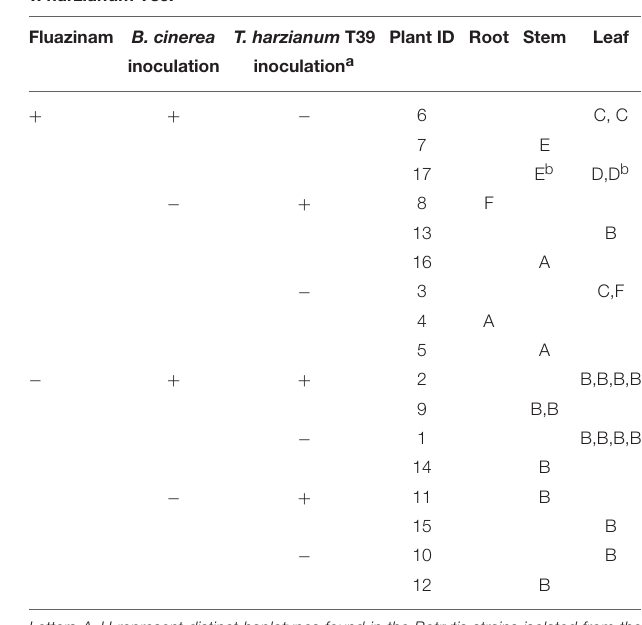
TABLE 5 | SSR genotypes, based on eight loci, of Botrytis isolates recovered from a randomized block factorial experiment on lettuce with treatments of fungicide seed treatment, spray inoculation with isolate ES13 (haplotype C) at the 4-leaf stage and soil inoculation with T. harzianum